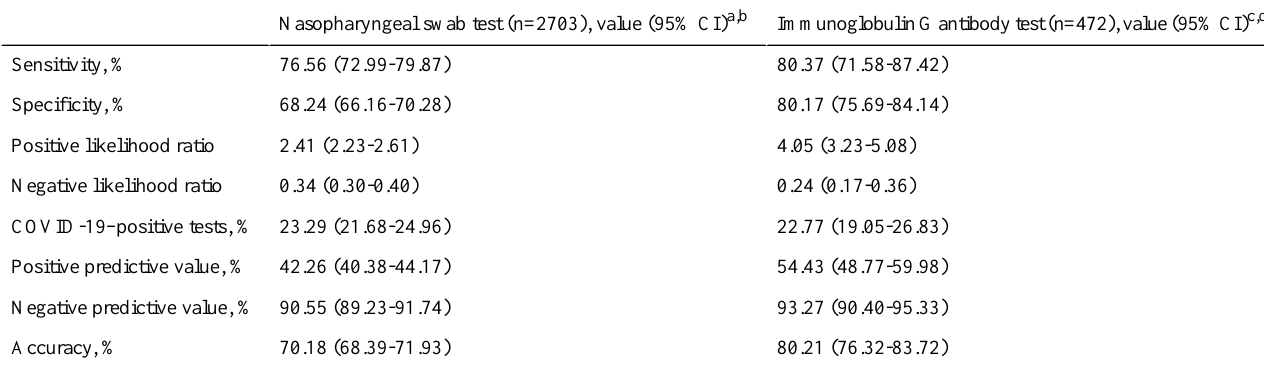
Table 4. Sensitivity and specificity of the EPICOVID19 diagnostic scale compared to those of positive COVID-19 molecular and serological diagnoses (ie, for subjects aged 18-84